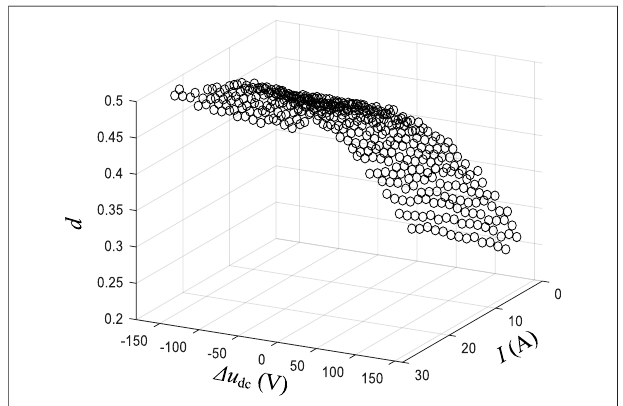
FIGURE 11 | Actual duty ratio of the training samples and the fi t duty ratio of the test samples.